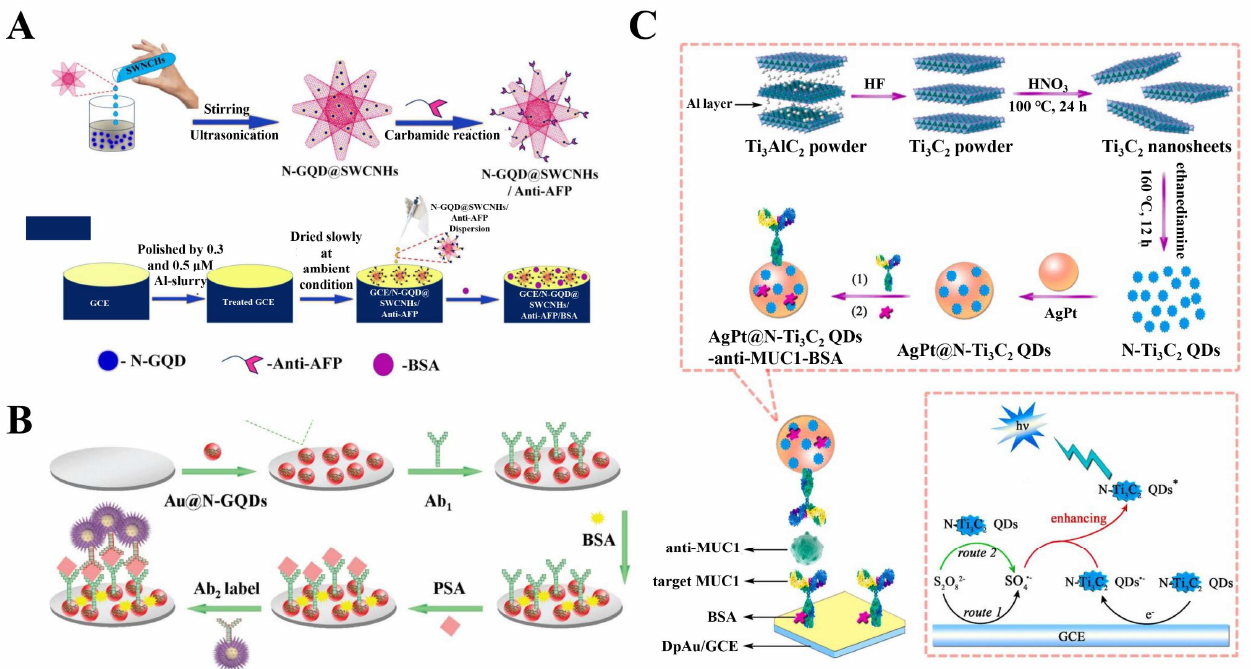
Figure 3. The 2D-QD-based electrochemical immunological sensors. ( A ) Preparation of